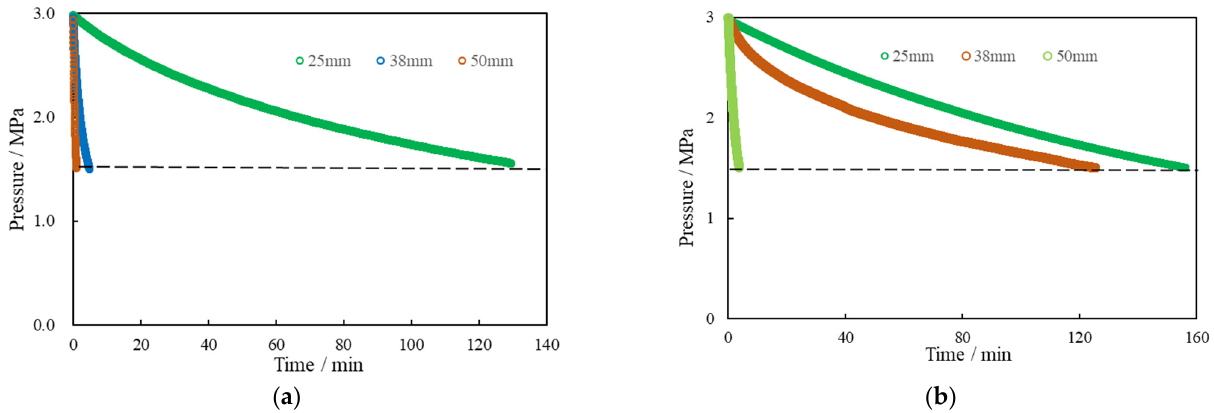
Figure 10. The influence of contact area on fracture connectivity. ( a ) Sample Y-#; ( b ) sample M-#.